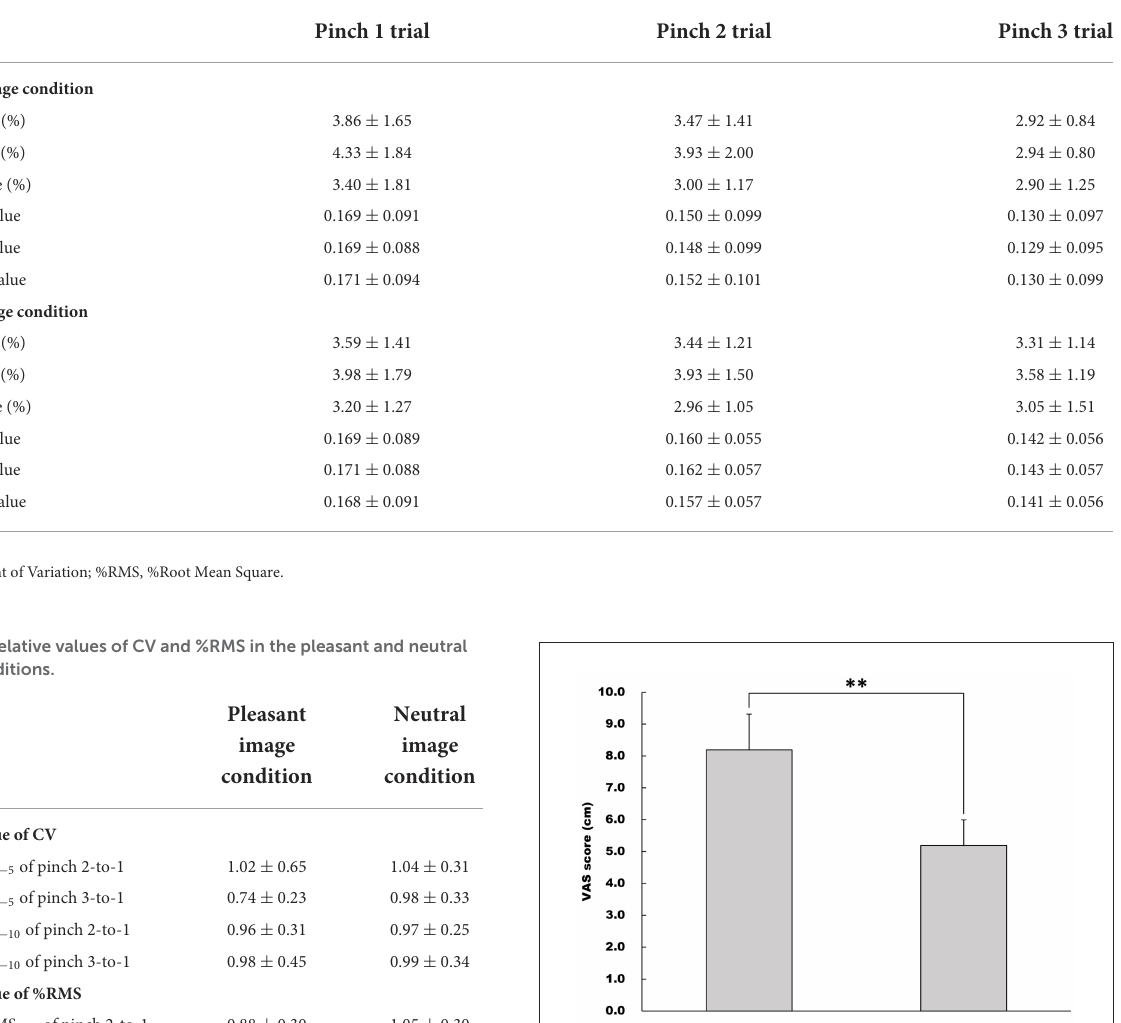
TABLE 3 CV and %RMS values in the pleasant and neutral image conditions.